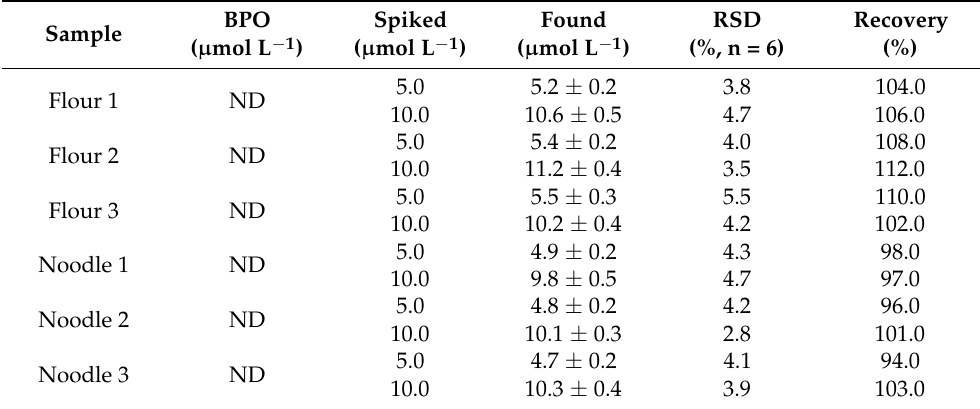
Table 1. Sensing results for BPO in flour and noodle samples.